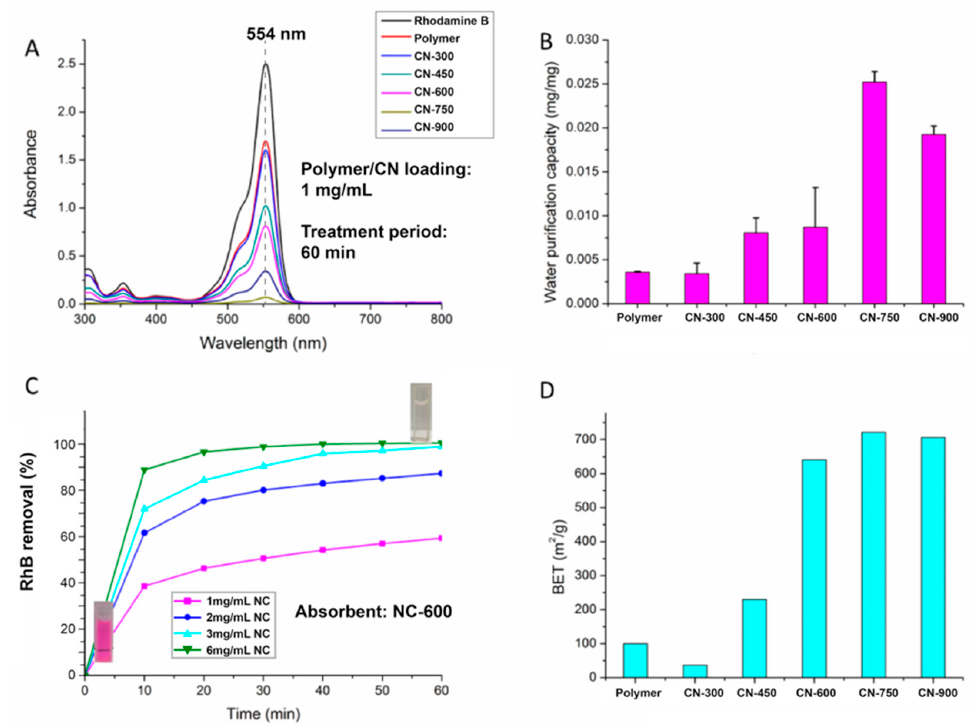
Figure 8. ( A ) The UV-visible spectra, ( B ) water purification capacity, ( C ) absorption curves, and ( D ) BET surface area of PAM and NCs.